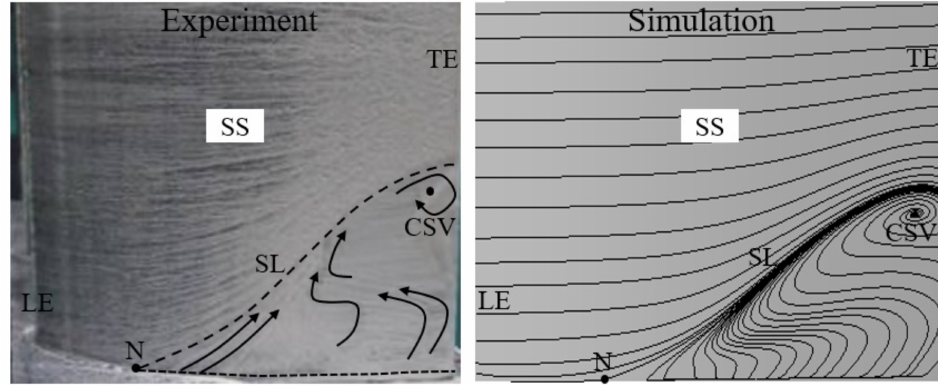
Figure 7. Experimental and simulation flow patterns on the blade SS of the original_2